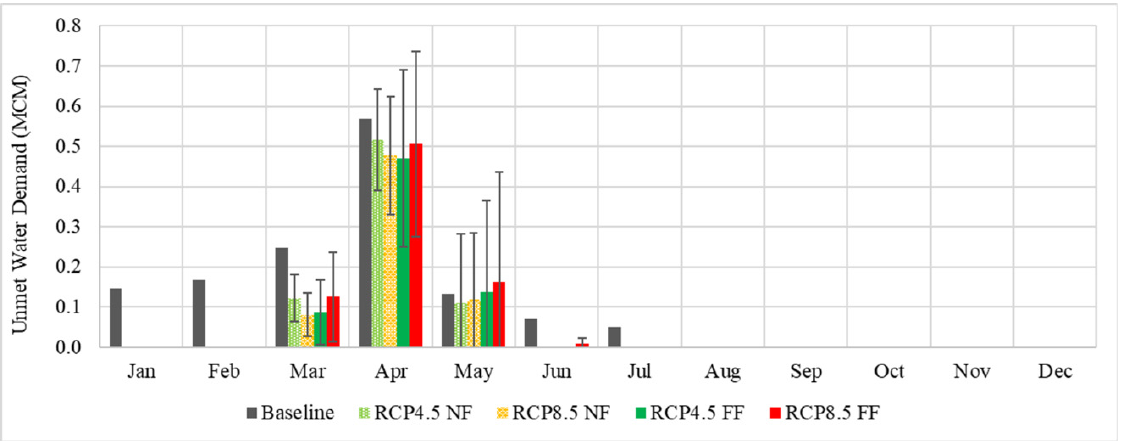
Figure 11. Unmet domestic demands in the SRB for baseline and future scenarios.